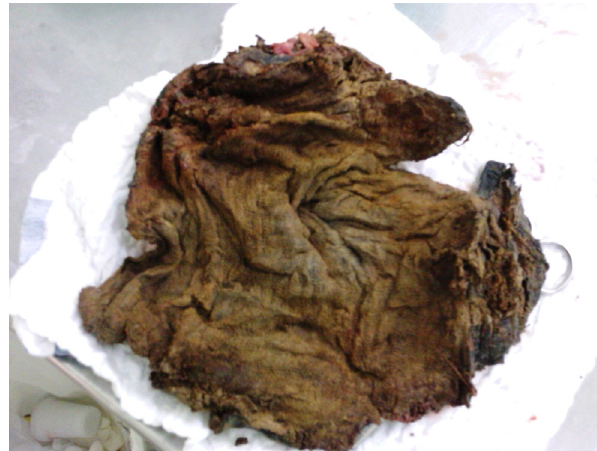
Figure 3 - The retained surgical